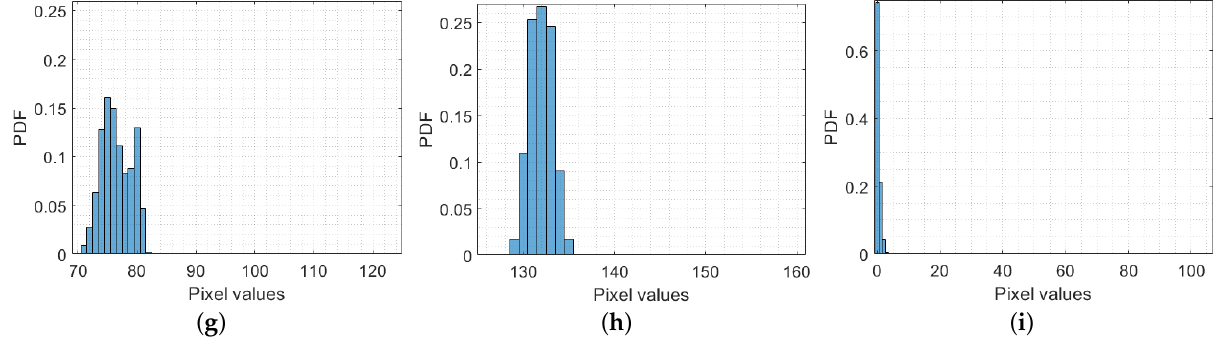
Figure 4. Distributions of the pixel values in color channels of the cropped images of Figure 1a (first row), Figure 1b (second row), and Figure 1c (last row), respectively. ( a ) Red channel of Figure 1a; ( b ) green channel of Figure 1a; ( c ) blue channel of Figure 1a; ( d ) red channel of Figure 1b; ( e ) green channel of Figure 1b; ( f ) blue channel of Figure 1b; ( g ) red channel of Figure 1c; ( h ) green channel of Figure 1c; ( i ) blue channel of Figure